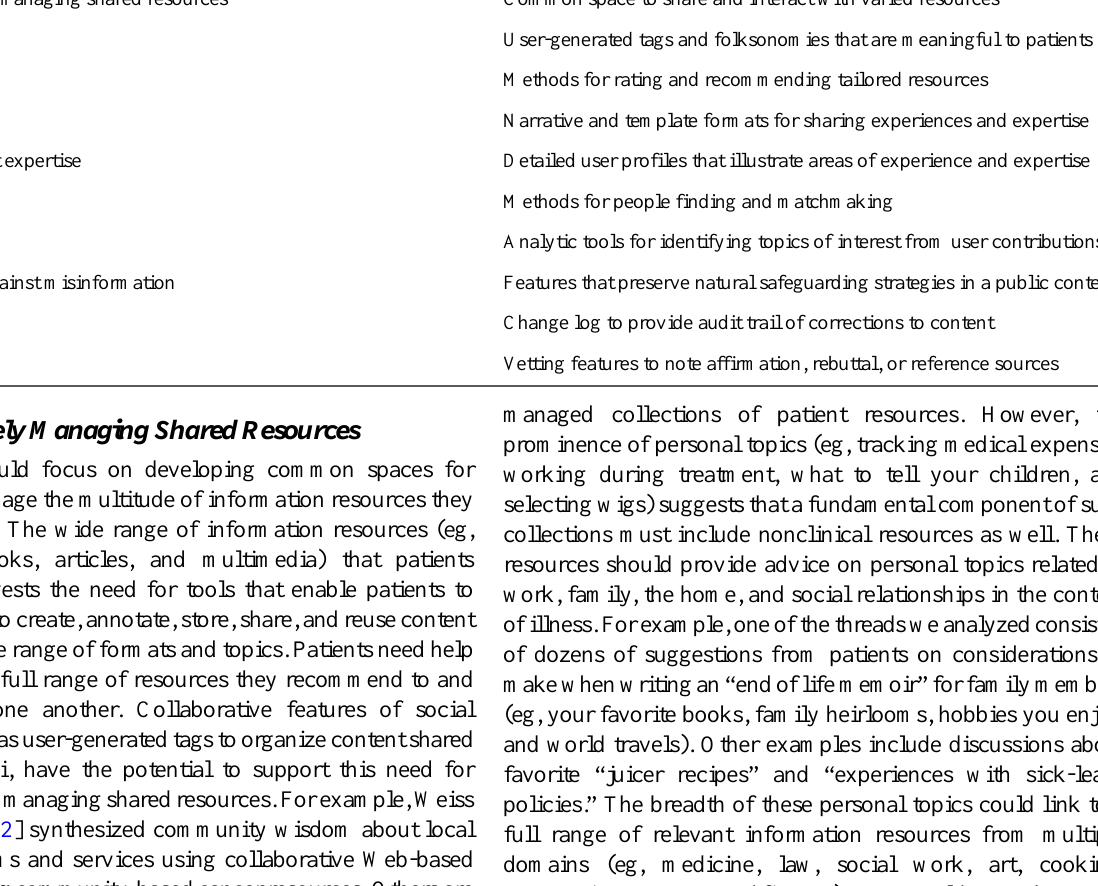
Table 5. Design opportunities to facilitate patient-expertise sharing